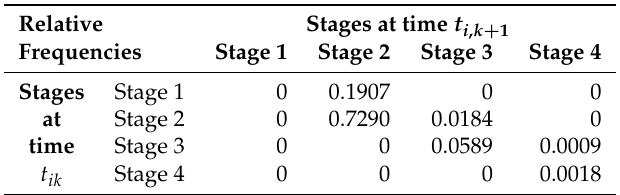
Table 6. Aneurysm data: relative frequencies of transitions between stages of the aortic diameter obtained with the proposed model for all the